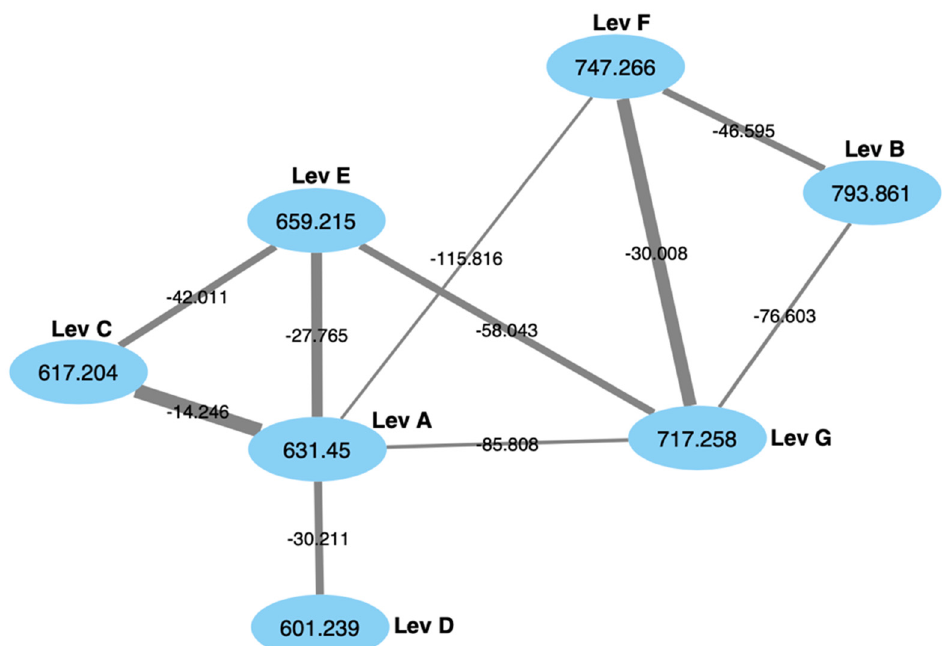
Figure 4. Global natural product social molecular networking cluster for the levesquamides, indicating a total of 7 family members, including levesquamide A (631), 6 analogues. Each node represents one ion, each is connected by an edge when the cosine score is ≥ 0.7, with the thickness of each edge representing the cosine score, and each edge is labelled with the m / z differences between the connecting nodes.